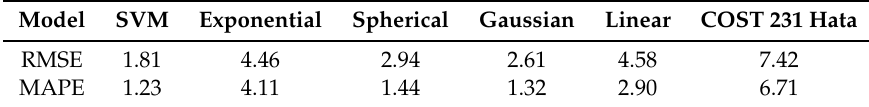
Table 2. Minimum root mean square error (RMSE) and mean absolute percentage error (MAPE) values for each variogram model and the COST 231 Hata